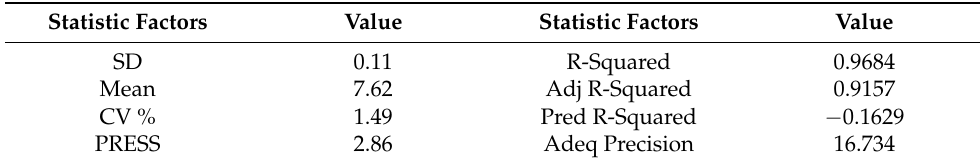
Table 6. ANOVA for models.